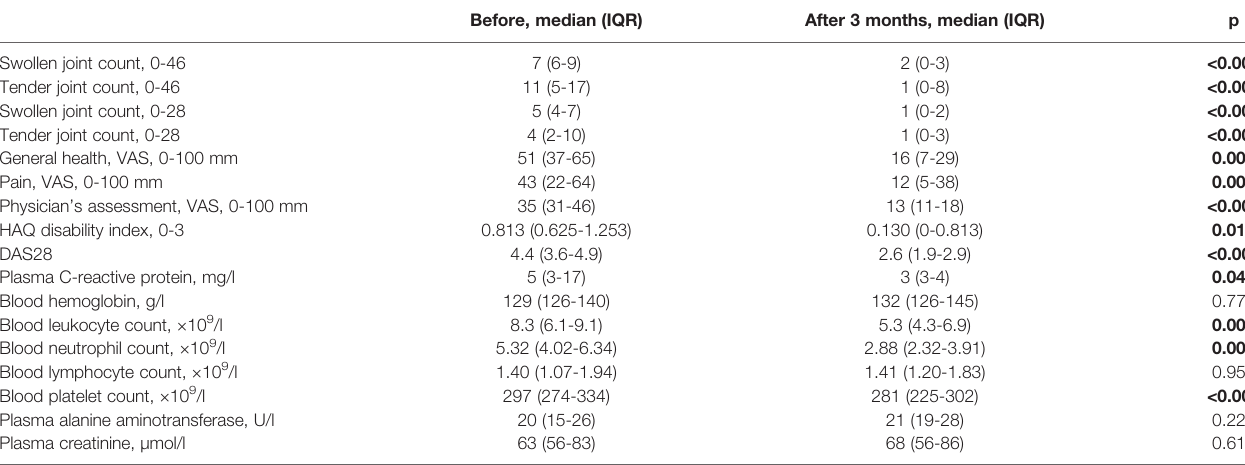
TABLE 2 | Comparison of clinical and laboratory parameters at baseline and after 3-month treatment with tofacitinib and csDMARDs.